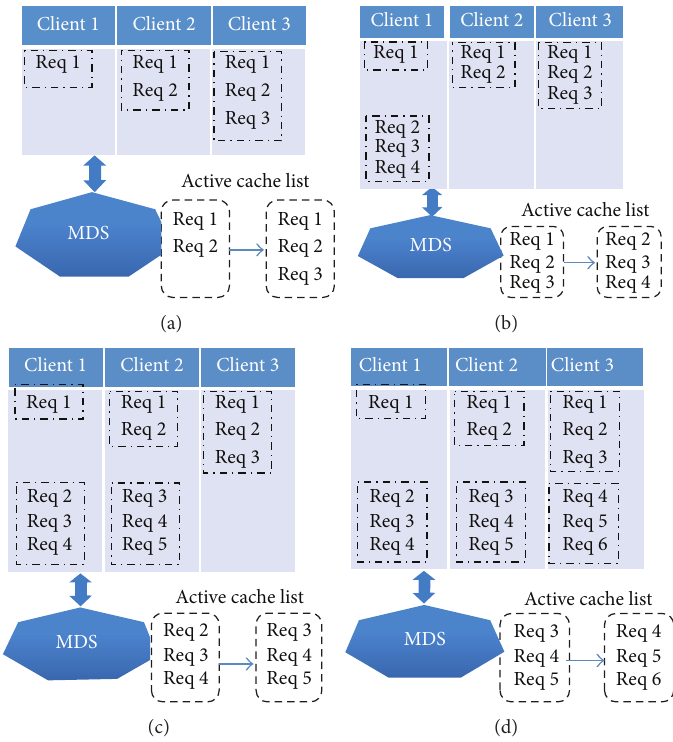
Figure 2: Backing up multiple requests on client side.